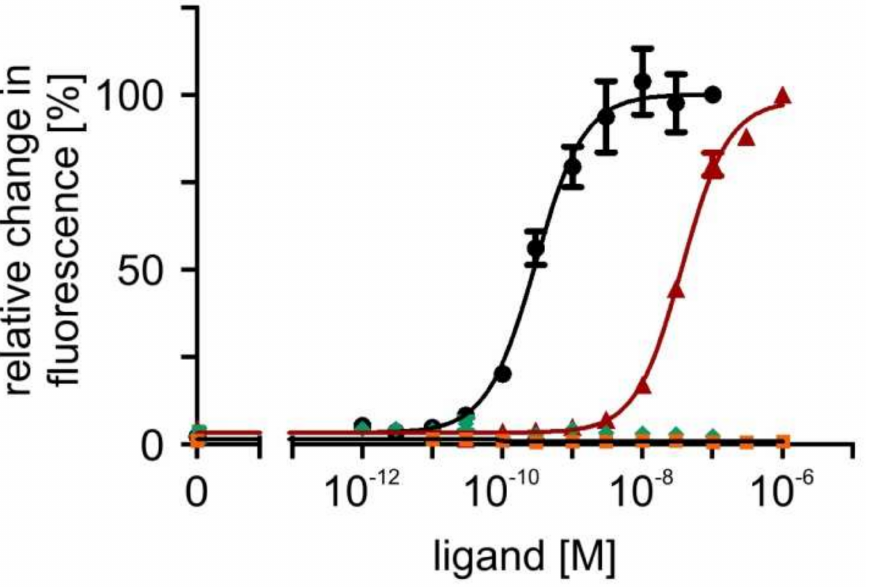
Figure 6. Concentration-dependent effects of octopamine and tyramine on [cAMP] i in PaOct β 2R- HA-expressing and flpTM (control) cells. Relative change in fluorescence (corresponding to the amount of cAMP) is given as the percentage of the value obtained with the highest octopamine or tyramine concentration (=100%). All measurements were performed in the presence of 100 µ M IBMX. Octopamine ( • ) and tyramine ( (cid:78) ) activation of PaOct β 2R-HA led to a concentration-dependent increase in the fluorescence signal. No change in the fluorescence signal was observed in flpTM cells (octopamine (cid:7) ; tyramine (cid:4) ). A total of five independent measurements were performed. Data points represent the mean ± SD of a representative eight-fold